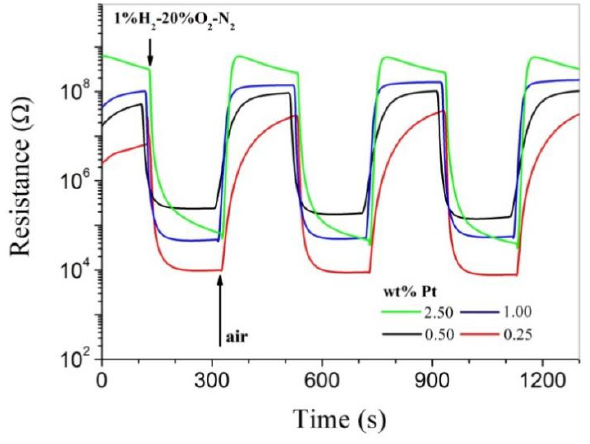
Figure 3. Room-temperature responses to 1.0% H 2 -20% O 2 -N 2 for as-pressed Pt-SnO 2 pellets with different Pt contents.